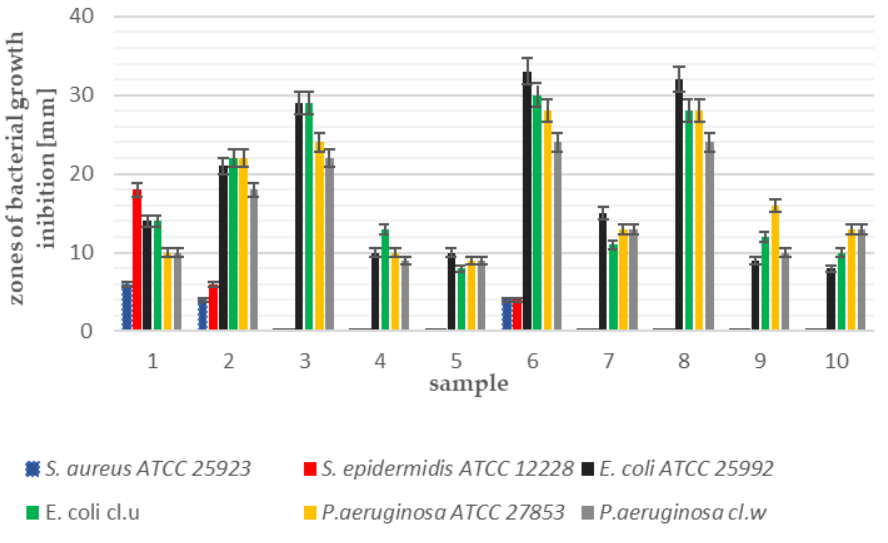
Figure 3: Zones of bacterial growth inhibition of EOs of Hemerocallis cultivars tested against Gram-negative and Gram-positive bacterial